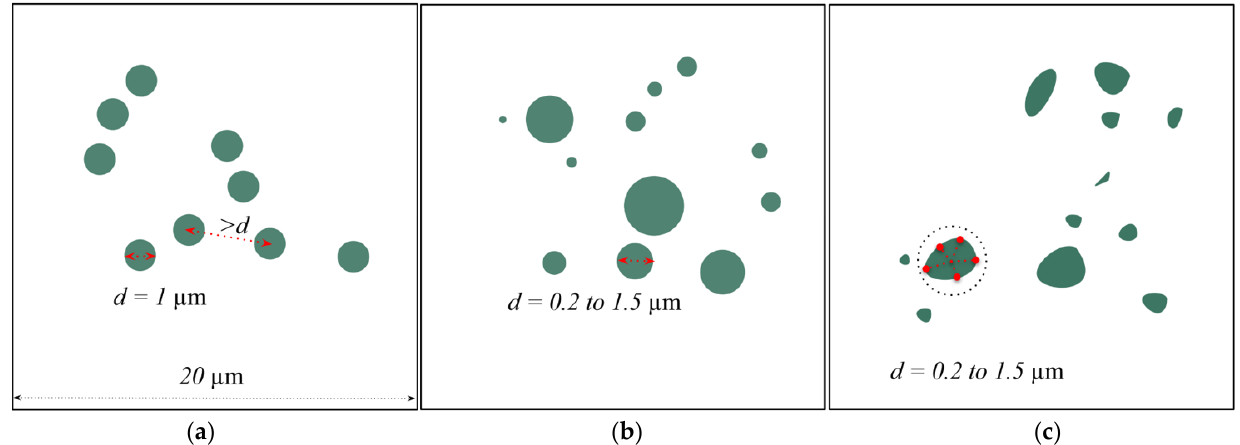
Figure 2. Three patterns of BGs embedded in the COL: ( a ) circular BGs shapes with the same diam- eter as a uniform dataset; ( b ) BGs distributed in the COL with circular shapes and different diameters as a non-uniform dataset; ( c ) free-shape BGs embedded in the COL as an irregular dataset.